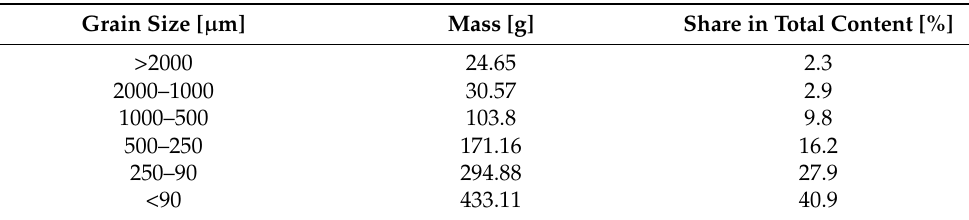
Table 1. Fractional composition of air-dried bottom sediments sample.